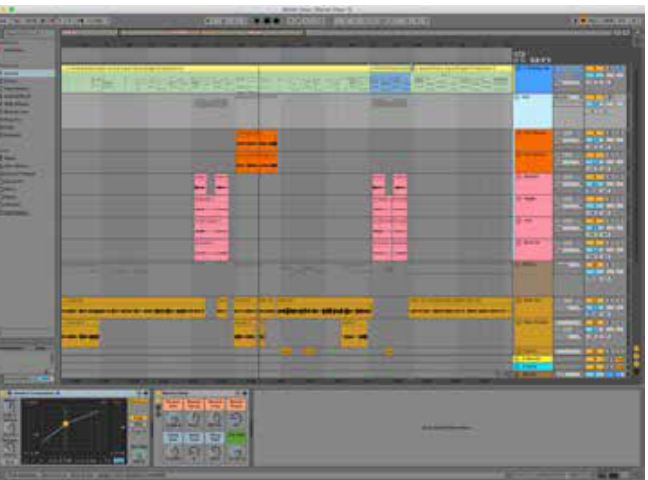
Figure 6: Digital audio workstation, Abelton Live session of Faith. Source: Sophy